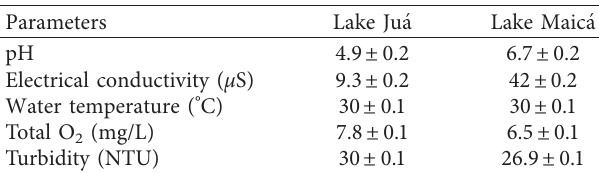
Table 2: Characterization of the physicochemical parameters of the water of the Lakes Ju´a and Maic´a, Santar´em, Par´a, Brazil, during the